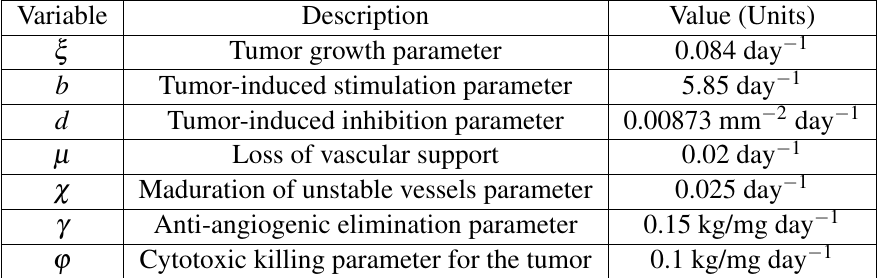
Table 5 Values of the biological parameters in the